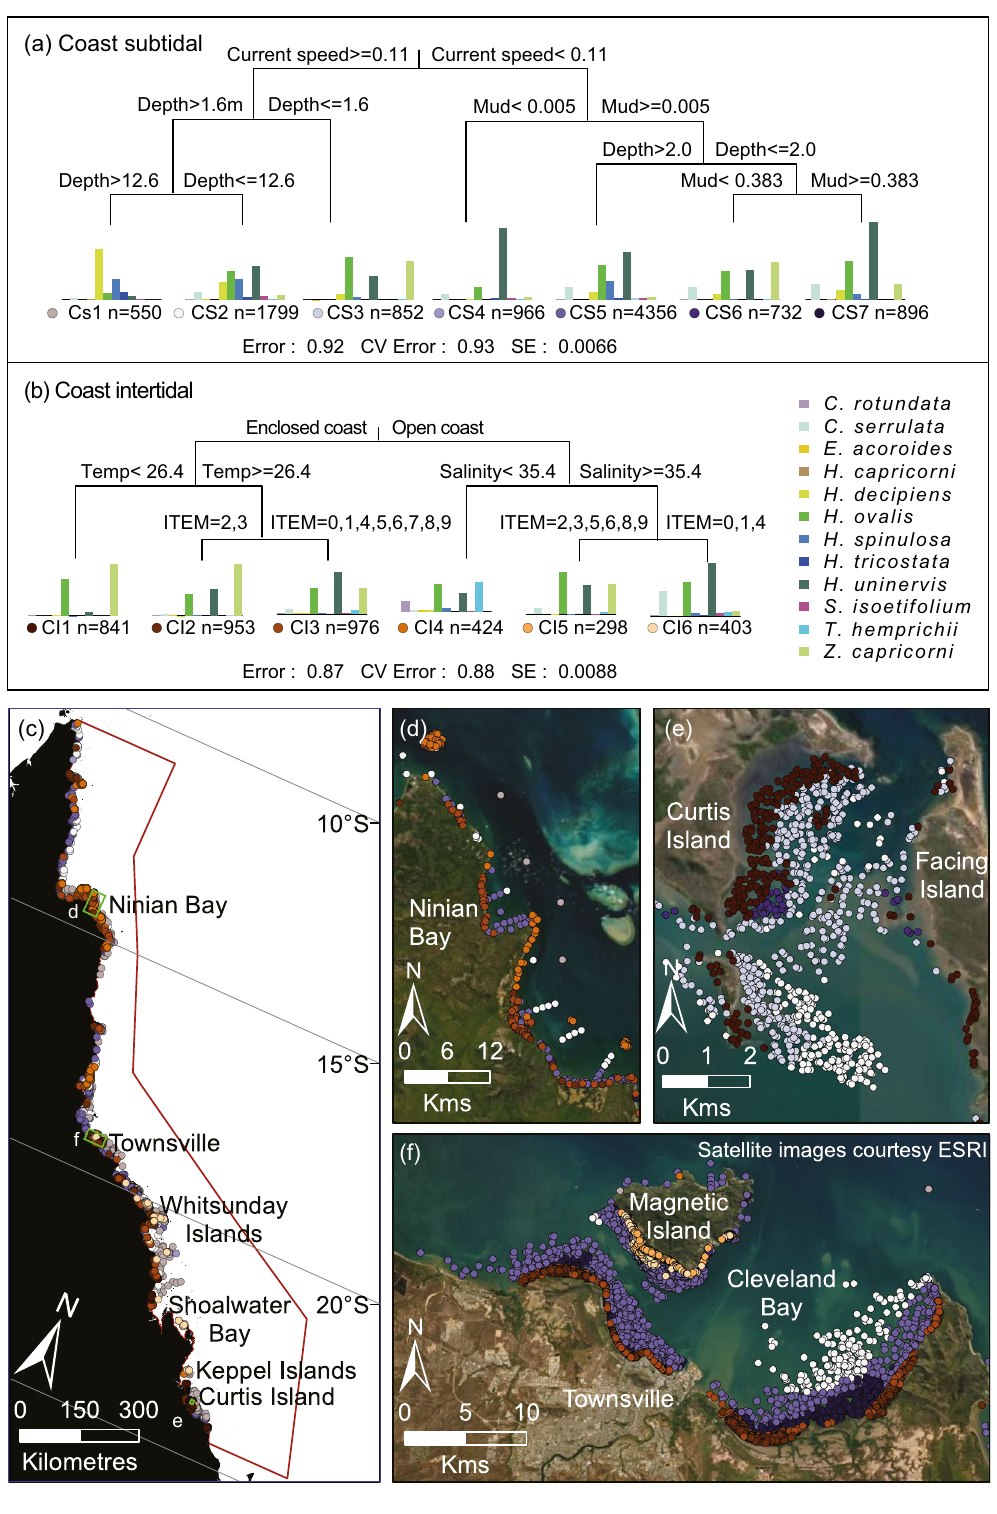
Figure 6. Multivariate regression tree (MRT) and seagrass communities classified for coastal waters using species presence/ absence data for ( a ) subtidal sites and ( b ) intertidal sites. The number (n) below each community is the count of observations that fall into that community. The histogram shows the frequency of occurrence for each species in that community with the height of the bar representing the frequency that each species was observed in that assemblage. The coloured dots represent unique communities for coast intertidal (CI) 1–6, and coast subtidal (CS) 1–7. The CV Error is the cross-validated relative error. ( c ) The spatial distribution of communities across the Great Barrier Reef World Heritage Area (red border), and ( d – f ) finer-scale maps of communities at select locations. Map created using ArcGIS software version 10.8 by Esri (www. esri. com). Satellite image copyright